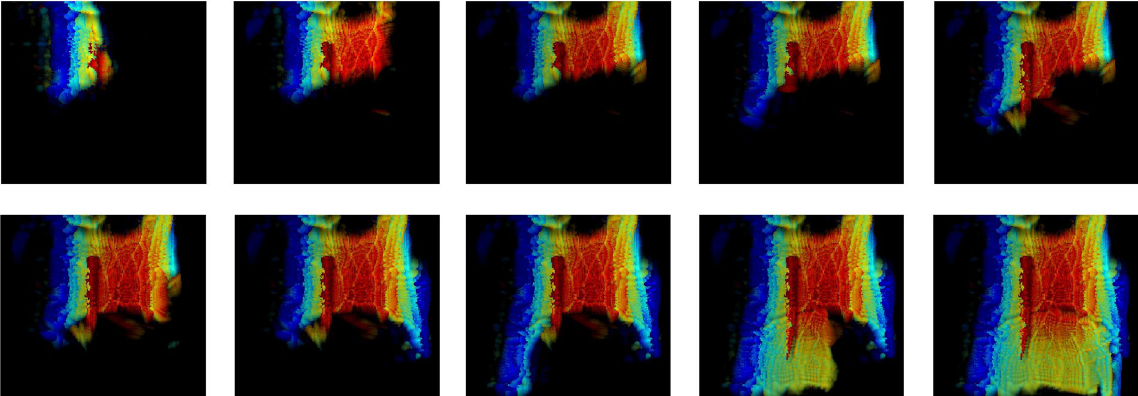
Figure 5. Accumulative Cumulative image for the simulation detailed in Fig. 4 after 3, 6, 8, 10, 13, 16, 18, 20, 23 and 26 scanner positions, respectively.